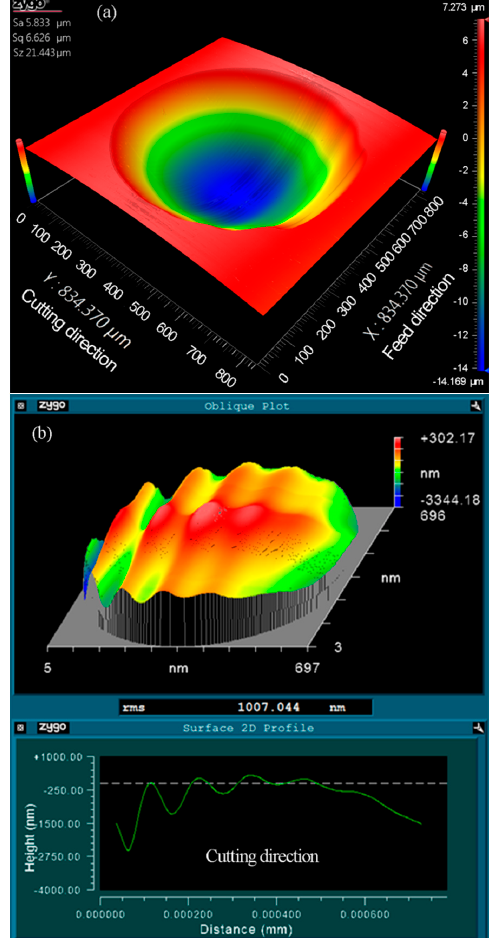
Figure 8. Zygo photographs of micro lens. ( a ) 3-D topography of machined micro lens; ( b ) The form error of machined micro lens surface from a designed sphere ( n = 100, t = 1 ms).